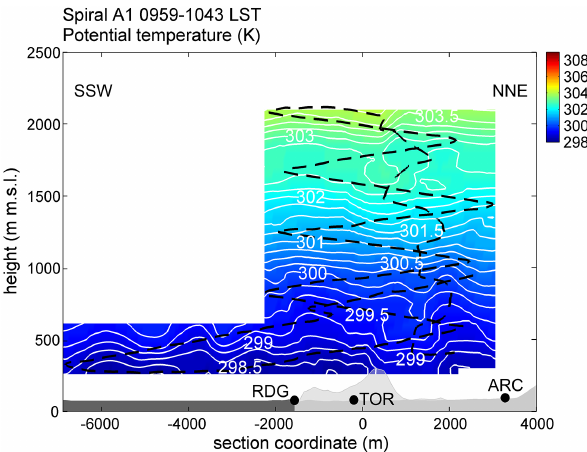
Figure 8. As in Fig. 7 but for a longitudinal (along-valley) verti- cal section. Dark grey shading indicates Lake Garda’s surface. The section is taken immediately W of Mt. Brione (in semi-transparent grey shading), i.e. in the middle of the Sarca Valley (cross-valley co- ordinate: 500m; cf. Fig. 7). Accordingly, the horizontal coordinate marks the along-valley direction. The projection of the position of RDG, TOR and ARC is also indicated (black dots).